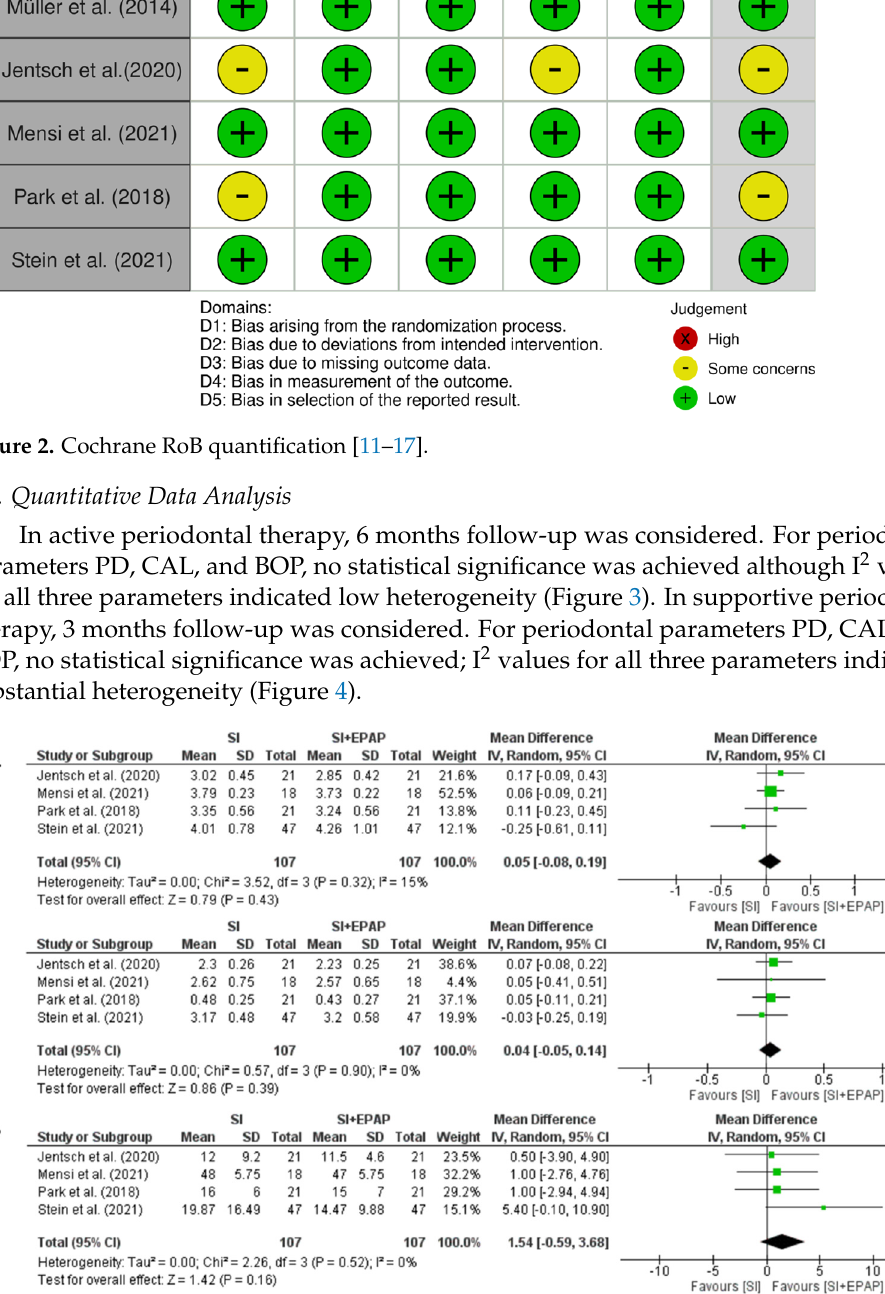
Figure 4. Erythritol in supportive periodontal therapy. 4. Discussion Our systematic review with meta-analysis evaluated the efficiency of erythritol air- polishing in non-surgical periodontal therapy (APT and SPT). Our findings suggest no superior efficiency in using erythritol air-polishing. In APT, forest plots graphics for periodontal parameters (PD, CAL, BOP) did not achieve statistical significance. An addition, in SPT, forest plot graphics for the same periodontal parameters did not achieve statistical significance. What can be depicted is that EPAP may be efficiently used in combination with hand or ultra-sonic scaling and root planning in order to control the levels of biofilm and reduce the periodontal inflammation. Although erythritol powder is used as an adjuvant to non-surgical periodontal therapy, it does not greatly reduce periodontal parameters in comparison to SRP procedures. In the meta-analysis of Abdulbaqi and coworkers [4], statistical significance was obtained for EPAP during APT for CAL parameter (0.16 mm; p < 0.02). The authors concluded that EPAP may be used as adjunct in APT and as an alternative to mechanical debridement in SPT. Furthermore, in the systematic review of